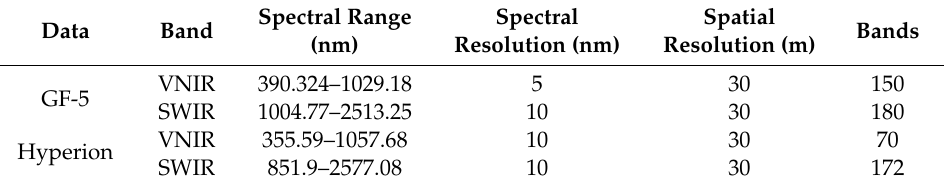
Table 1. The characteristics of hyperspectral data from GF-5 satellite and Hyperion data.